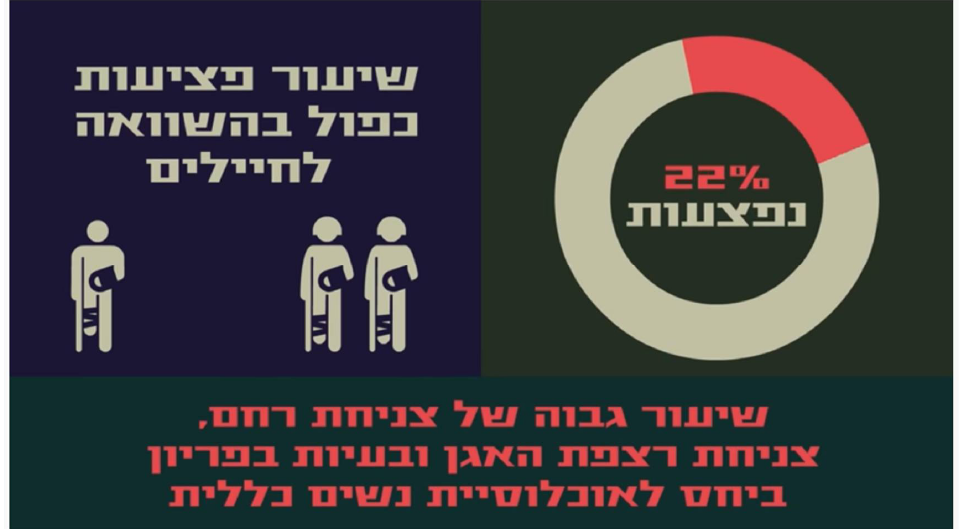
Figure 7. ‘A folk tale’ (Brothers at Arms, April 2017). [Hebrew wording on the slide, top to bottom, right to left: “22% are injured”; |rate of injuries are double comparted to male soldiers”; “high rates of uterine prolapse, pelvic organ prolapse and fertility issues compared to the general female population”] (Supplementary Materials).